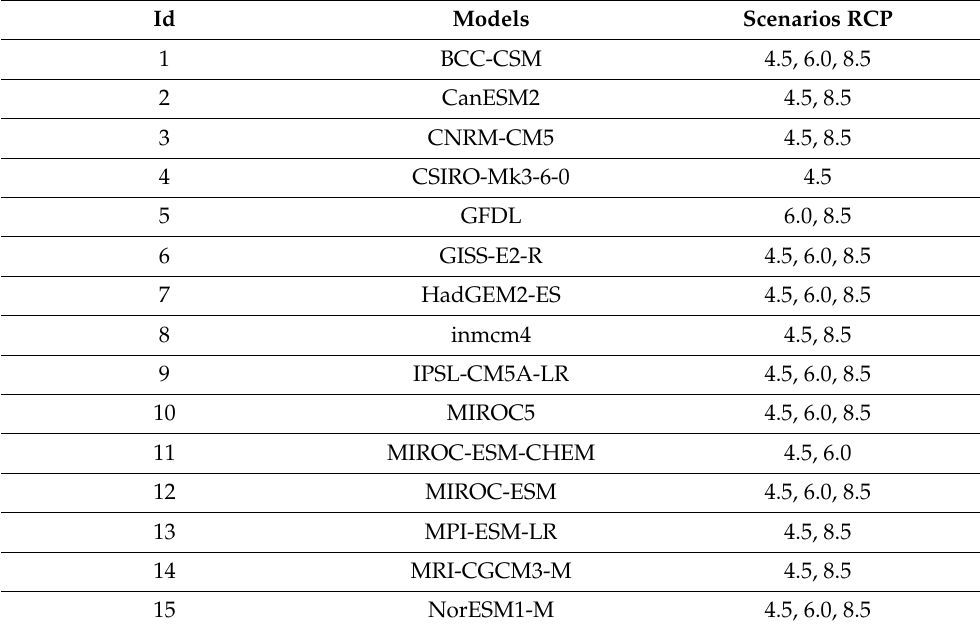
Table 1. Fifteen Global Coupled Models from